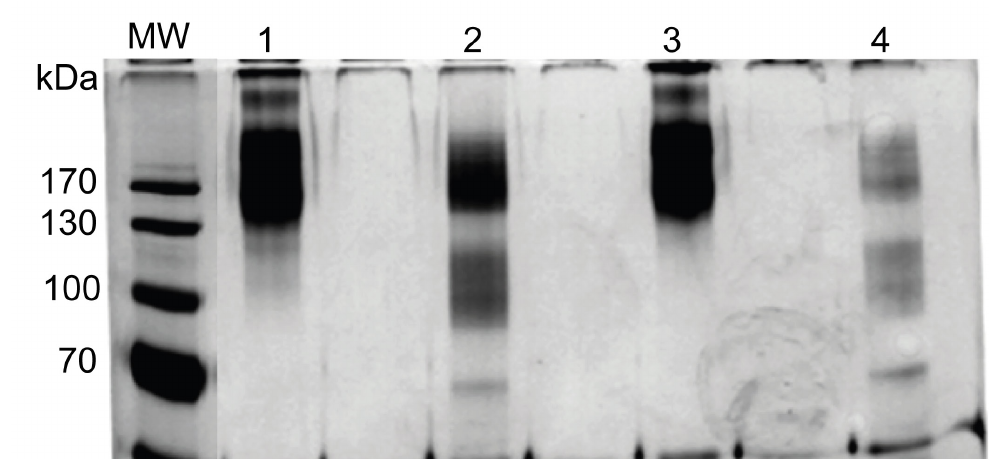
FIGURE 2 - Generation of F(ab)’ fragments obtained from anti-bothropic antibodies using bromelain or ficin. 10 % SDS-PAGE, 2 fragments obtained by bromelain digestion (lanes 1 before digestion and 2 after digestion) under reducing conditions, of F(ab)’ 2 and ficin digestion (lanes 3 before digestion and 4 after digestion) of anti-bothropic serum. Samples were applied at 10 µg of protein content per line to analyze the digestion